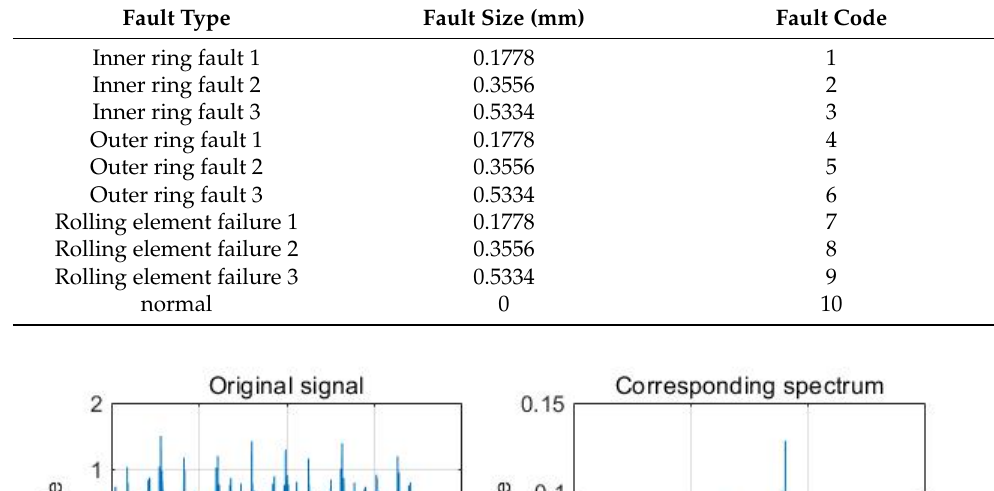
Table 1. Fault type and fault code.